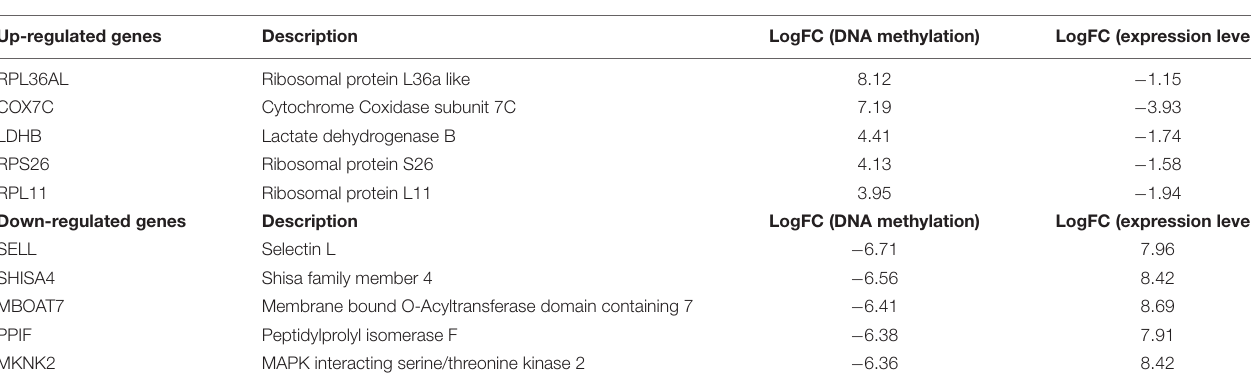
FIGURE 4 | By analyzing two datasets, GSE97760 and GSE109887, a cluster heatmap of the top 10 DEGs between AD and normal controls was obtained. (A) Expression levels of DEGs. (B) DNA methylation of DEGs. TABLE 1 | Differential expression level and DNA methylation level of the top 10